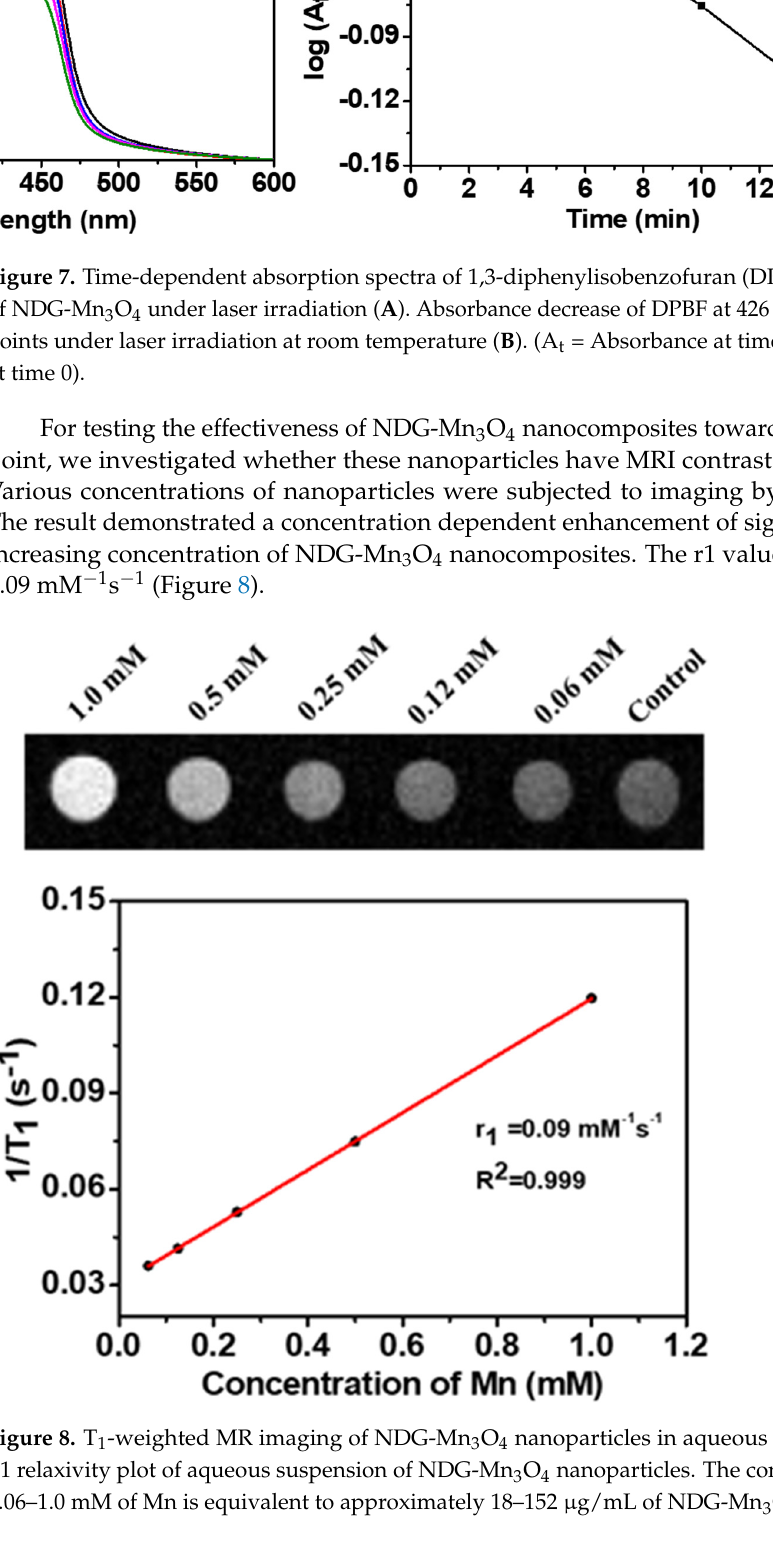
Figure 8. T 1 -weighted MR imaging of NDG-Mn 3 O 4 nanoparticles in aqueous suspension and the T1 relaxivity plot of aqueous suspension of NDG-Mn 3 O 4 nanoparticles. The concentration range of 0.06–1.0 mM of Mn is equivalent to approximately 18–152 µ g/mL of NDG-Mn 3 O 4